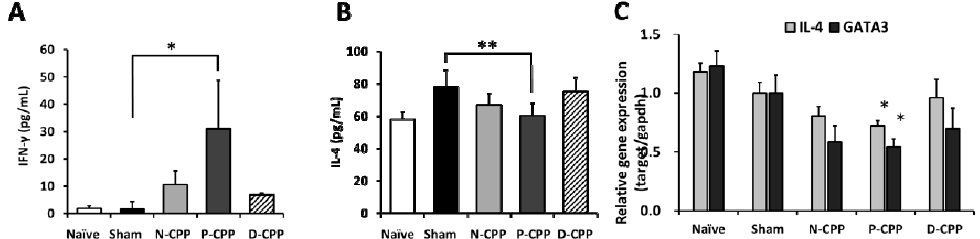
Figure 4. Effects of oral feeding with differently phosphorylated CPP-III on cytokine production and gene expression of OVA-sensitized mice. OVA-sensitized mice were fed differently phosphorylated CPP-III for a period of 6 weeks, and the collected spleen (SP) cells were incubated with PBS (unstimulated) for normal group and stimulated with 50 µ g/mL (final concentration) of OVA for the control, N-CPP, P-CPP, and D-CPP groups. The levels of IFN- γ ( A ) and IL-4 ( B ) in the culture supernatant after incubation for 72 h were determined by sandwich ELISA. Relative mRNA expression levels of IL-4 and GATA-3 ( C ) were determined by qPCR ( C ). Data represent the mean ± SE of individual mice in the group. * p < 0.05; ** p < 0.01 vs sham group.